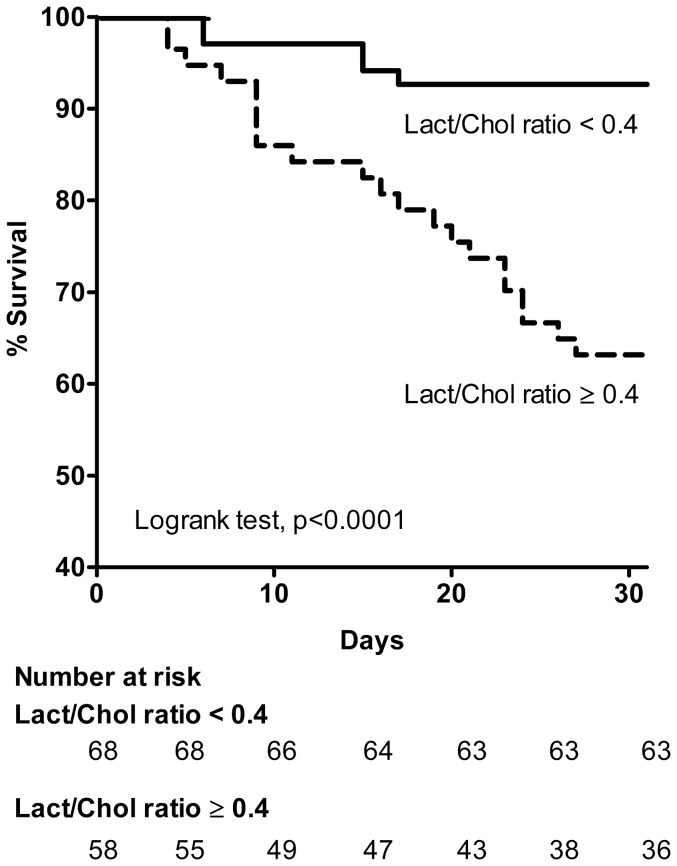
Survival analysis of the patients according to the cholesterol to lactate ratio.Kaplan−Meier curve estimation of the survival rate of the patients according to the cholesterol to lactate ratio at the cutoff value. A total of 126 AHF patients (training cohort) were included in this analysis based on Cobas Mira+ automated enzymatic detection of venous plasma lactate and cholesterol. Bold and dashed lines are for lactate/cholesterol ratio <0.4 and ≥ 0.4, respectively. Number at risk indicates over time the number of survival patients within each group based on lactate to cholesterol ratio (<0.4 and ≥ 0.4).